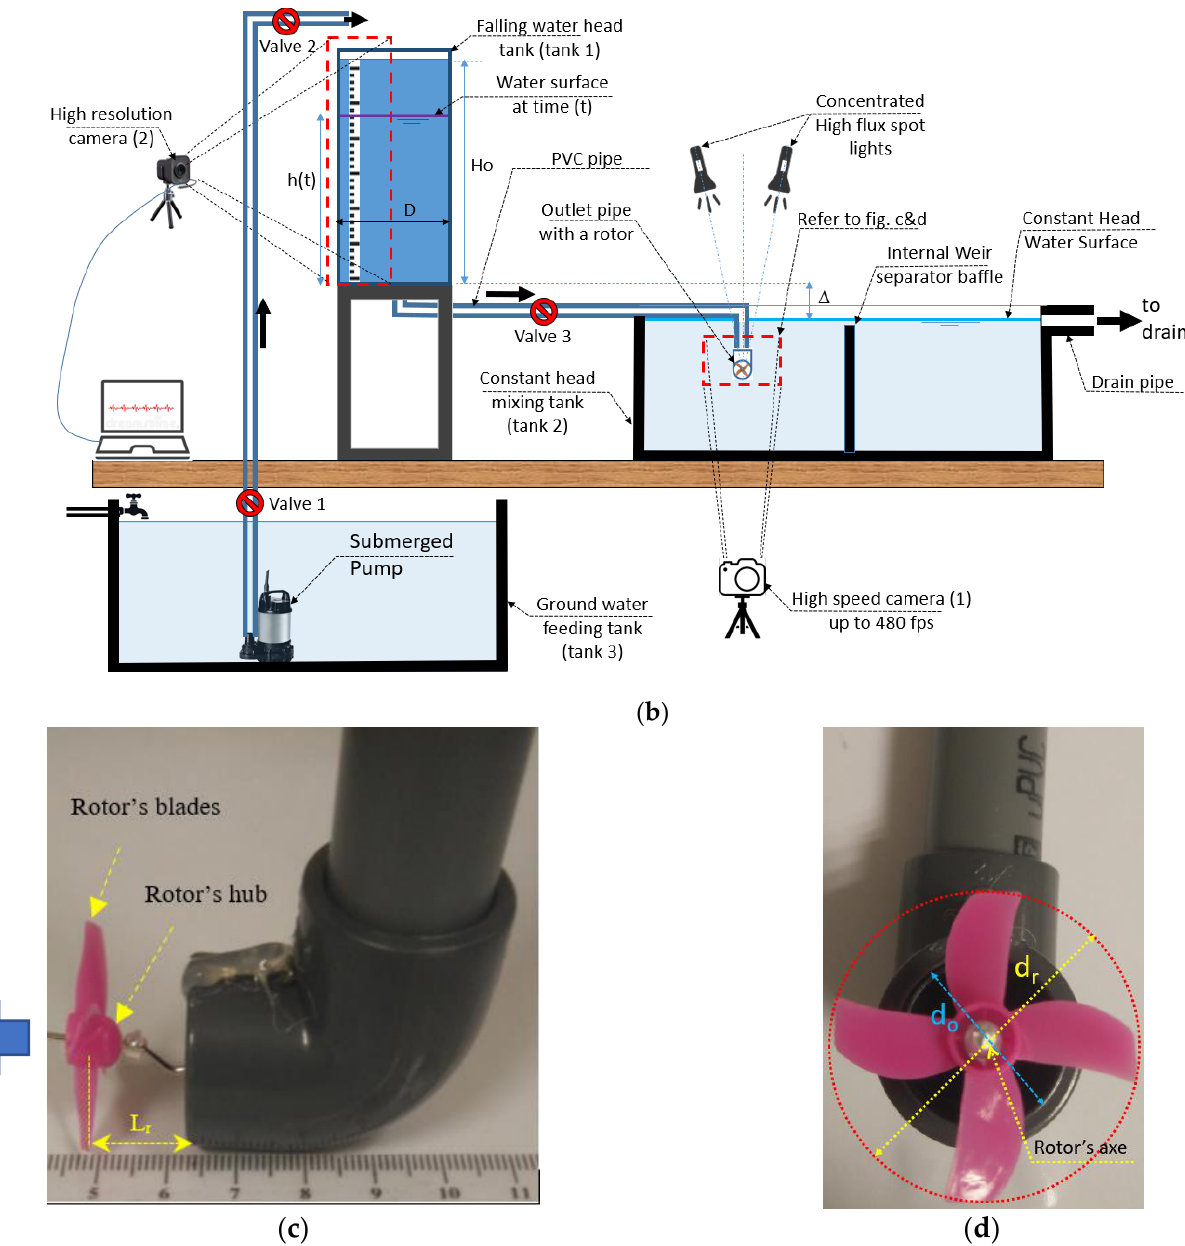
Figure 1. Experimental setup: ( a ) snapshot of the experimental setup; ( b ) schematic of the experimental setup; ( c ) side view of a pipe outlet with a passive rotor; ( d ) front view of pipe outlet with a symmetric 4-blade rotor.